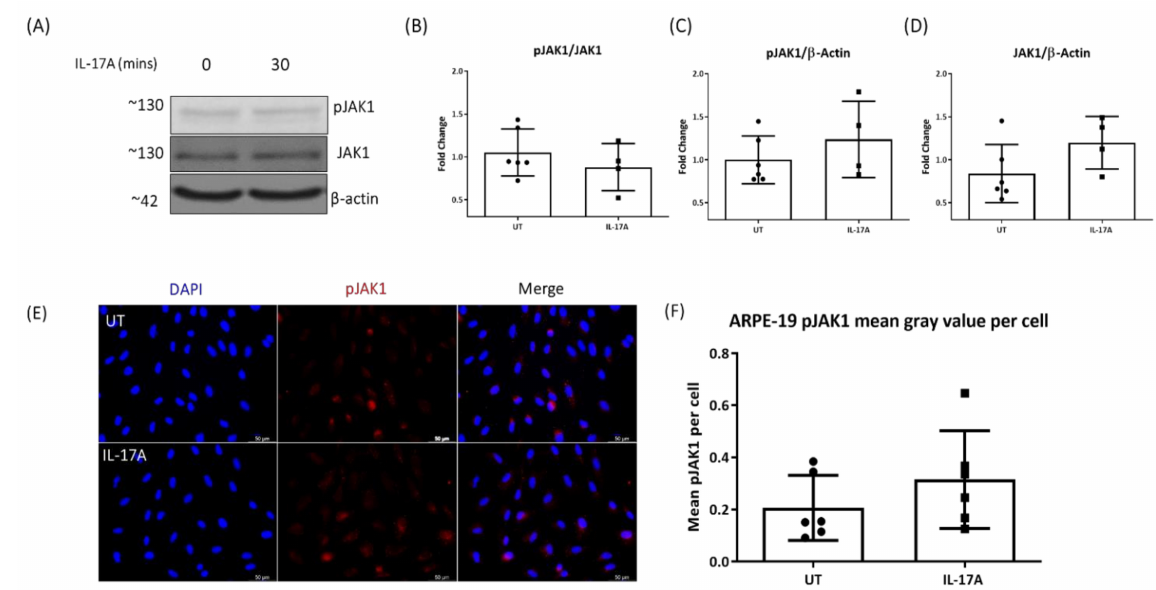
Figure 3. IL-17A does not significantly alter pJAK1 expression in ARPE-19 cells. Western blot ( A ) and corresponding ( B – D ) densitometry analysis of pJAK1, JAK1 and β -actin. ( E ) Representative immunostaining for pJAK1 (red) in control (UT) and IL-17A-treated ARPE19 cells, and ( F ) corresponding quantification. UT: untreated control.